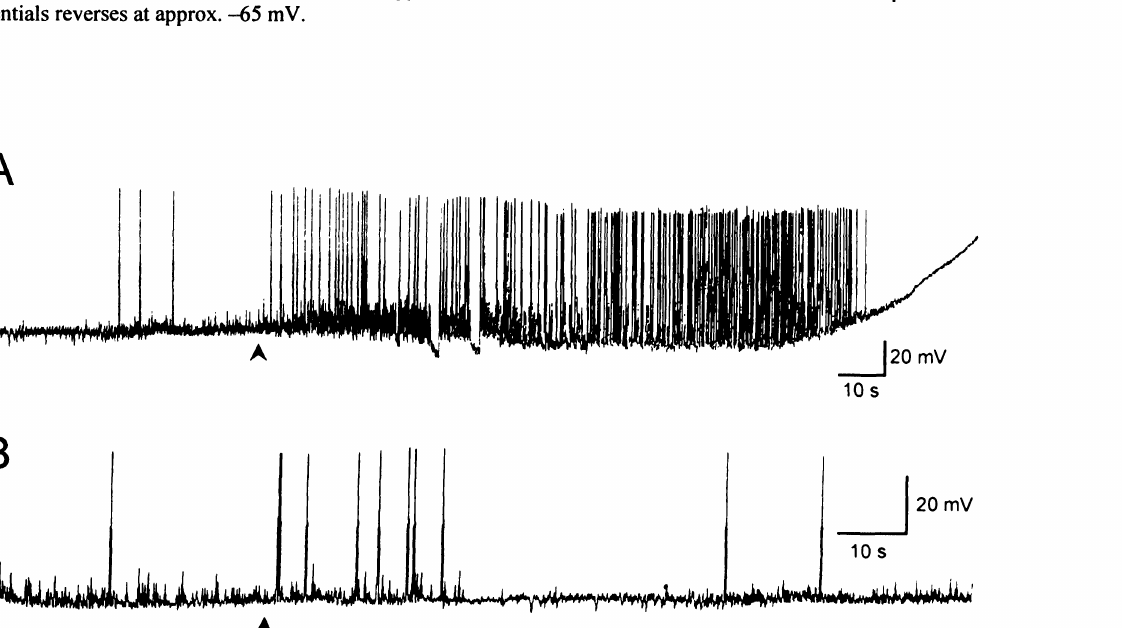
Fig. 7" Effect of pharmacological agents on the spontaneous activity of MNH neurons. The arrowheads indicate the time of bath application. A: NMDA (2 mM final concentration) leads to an increase of spontaneous activity and finally the breakdown of the neuron’s membrane potential. B: Bicuculline (5 laM) reversibly changed the neuron’s spontaneous activity. After an initial burst of action potentials, the number of spontaneous EPSPs